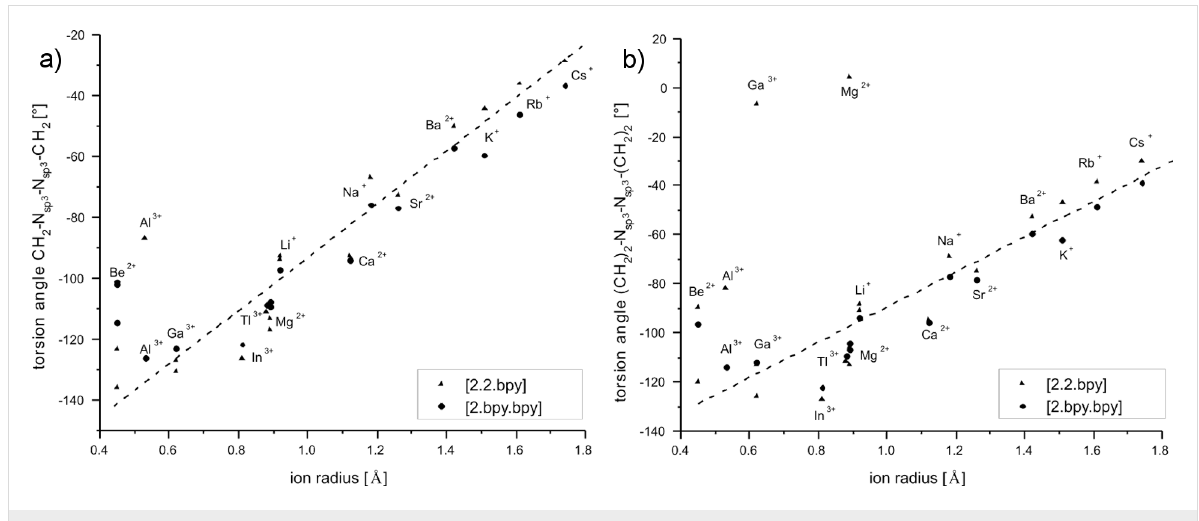
Figure 12: RB3LYP/LANL2DZp torsion angles CH 2 –N sp3 –N sp3 –CH 2 (a) and (CH 2 ) 2 –N sp3 –N sp3 –(CH 2 ) 2 (b) for [M 2.2.bpy] m+ and [M 2.bpy.bpy] m+ plotted against the ionic radius of M m+ (dashed line represents the observed trend).